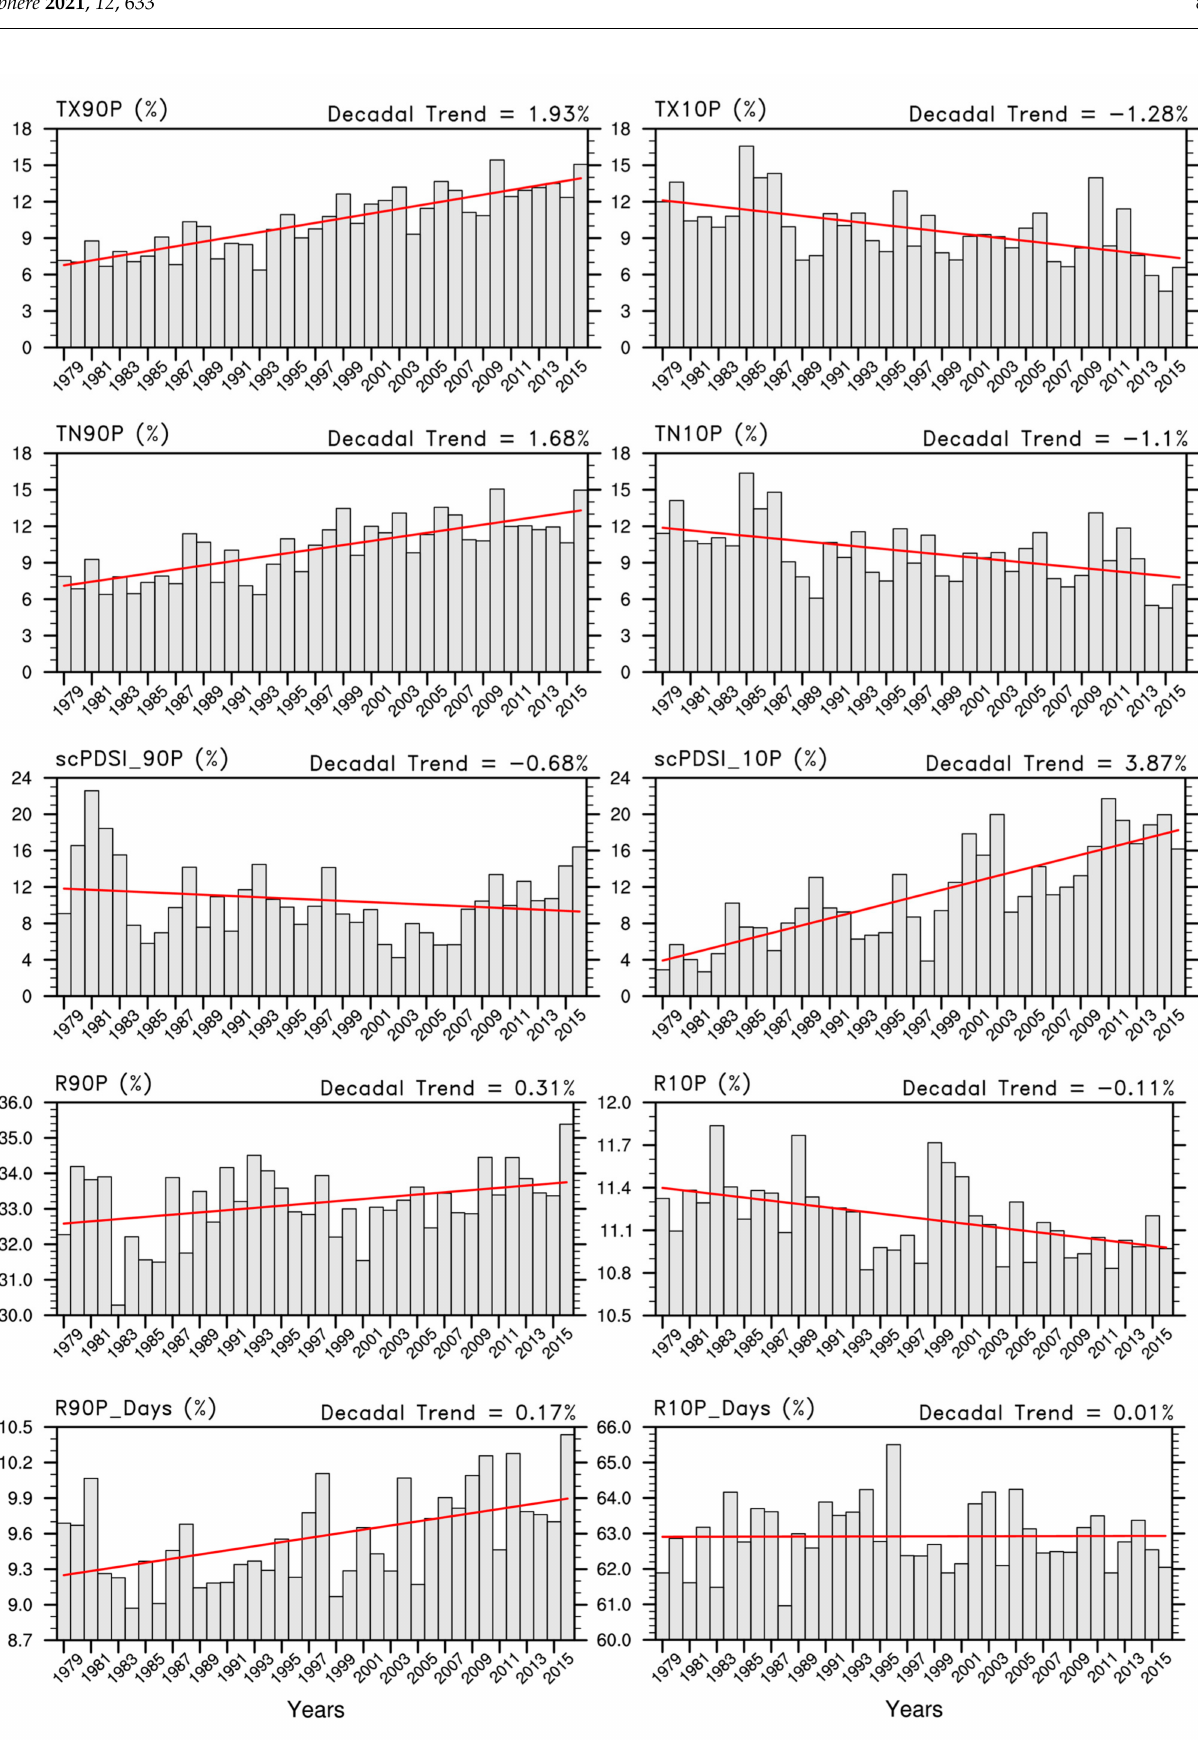
Figure 5. Spatial averages of the extreme indexes over the EURO–MED